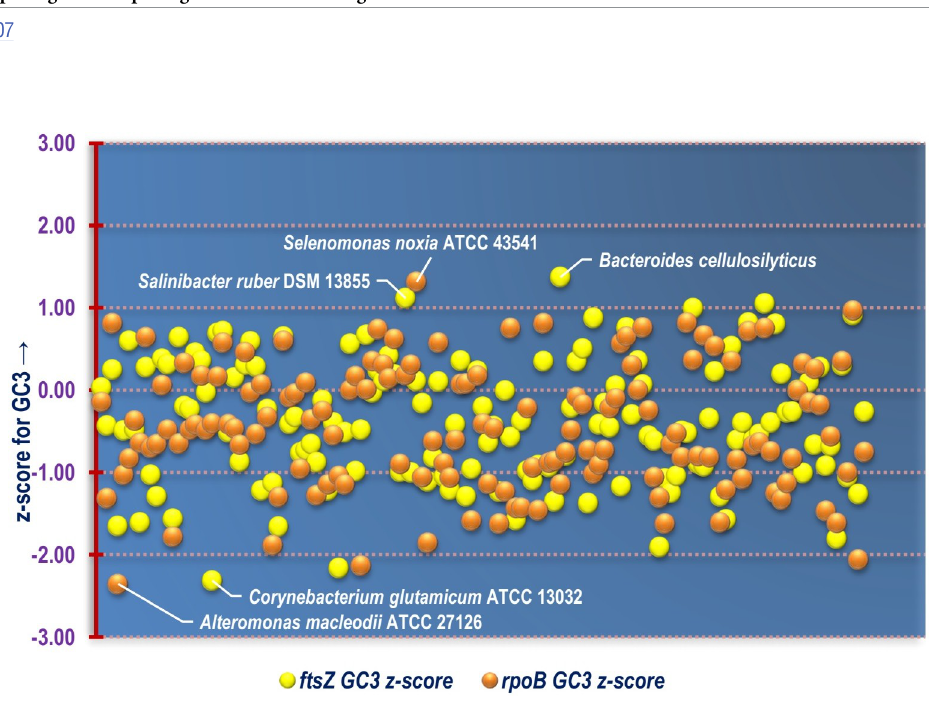
Fig 7. A scatter plot showing the distribution of the percentage of genes with GC3 less than that of ftsZ and rpoB residing within the genome of each of the organism segregated on the basis of the non-pathogenic and pathogenic nature of the organism.